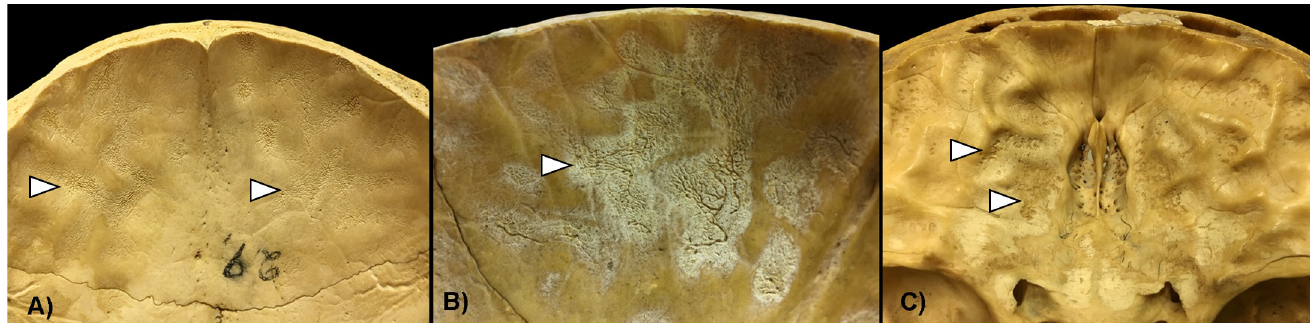
Fig 5. Co-occurrence of ABVIs and PAs with each other and with other probable TBM-related bony changes (white arrows). A) ABVIs and PAs in the abnormally pronounced digital impressions on the squamous part of the frontal bone (Terry No. 254, 21-year-old, male, died of pulmonary TB); B) ABVIs and PAs on the squamous part of the frontal bone (Terry No. 306, 18-year-old, female, died of pulmonary TB); and C) PAs accompanied by granular impressions on the orbital part of the frontal bone (Terry No. 1159, 26-year-old, male, died of pulmonary TB).